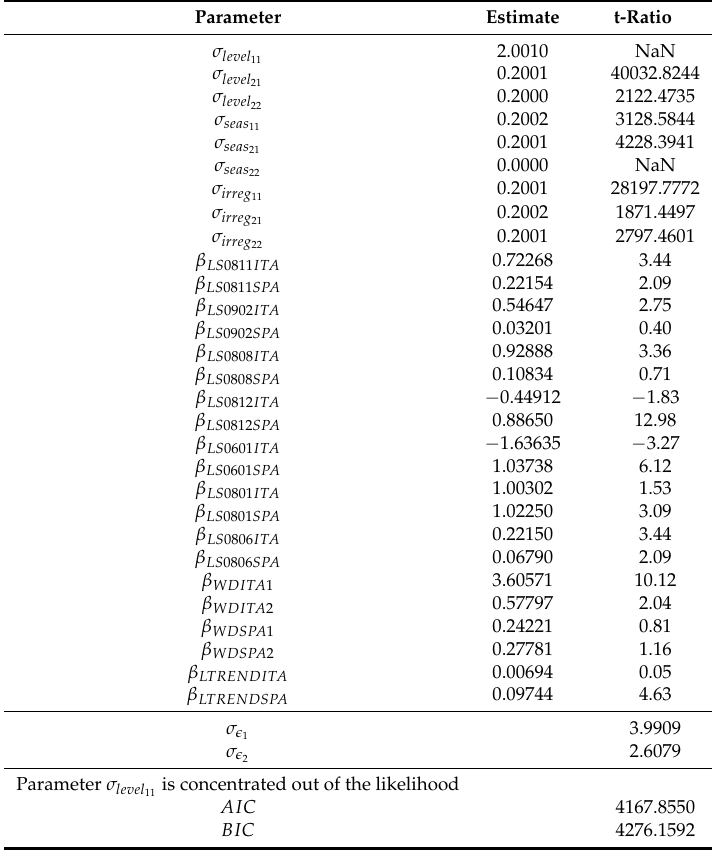
Table A13. Endogenous variables: IPI t capital goods LCVES t in